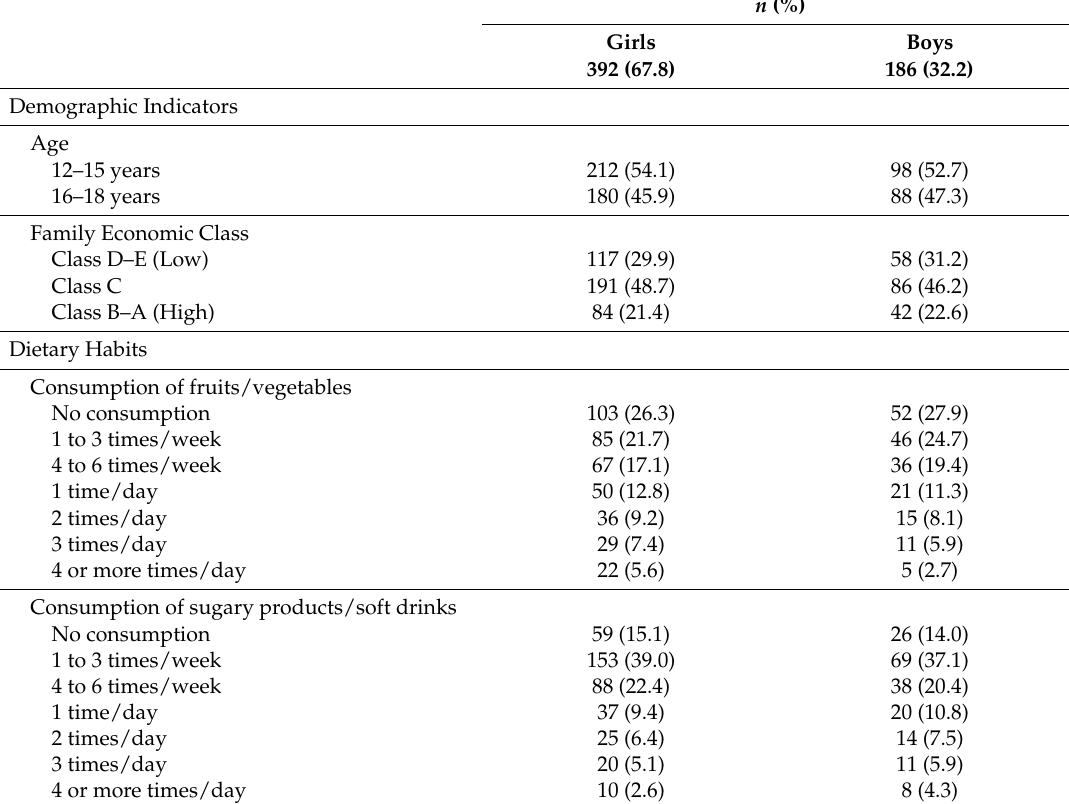
Table 1. Descriptive information of the sample selected in the